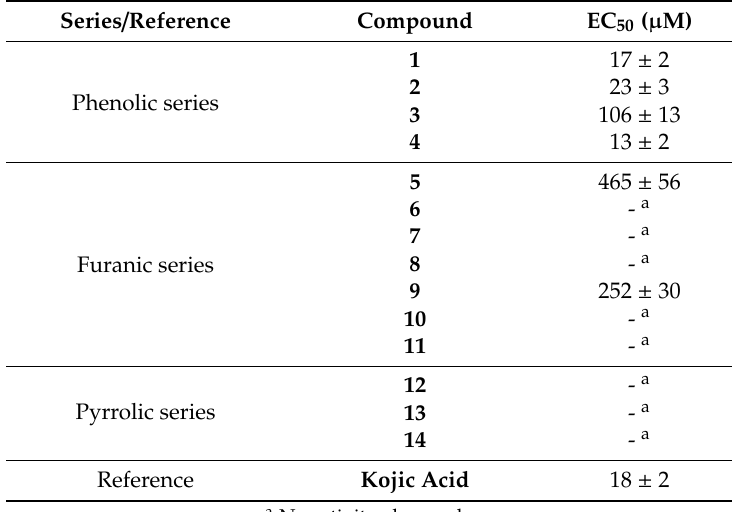
Table 2. EC 50 of synthesized molecules for mushroom tyrosinase